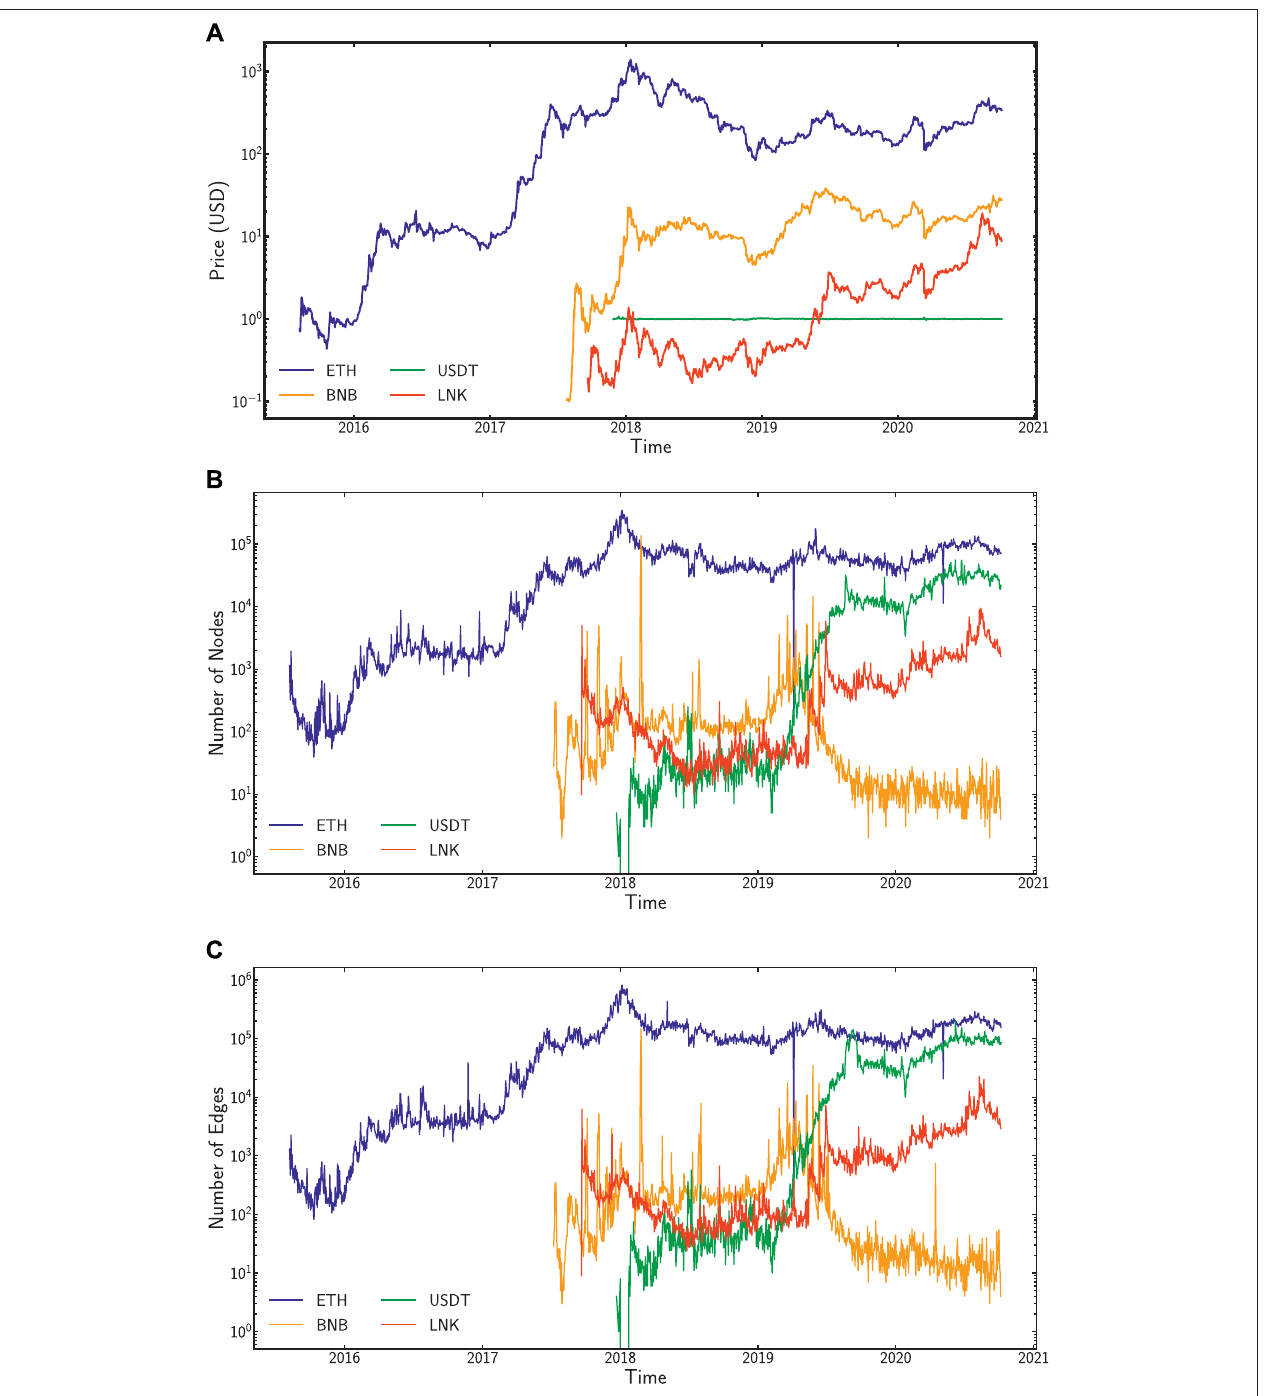
FIGURE2| Weplotbasicstatisticsofthedataanalysed.Inthe (A), weshow,asafunctionoftimetheclosingdailymarketpriceofETH,BNB,USDT,andLNKinUS Dollars. For the tokens, the time series begins with the deployment of the smart contract into the blockchain. In the (B,C), we show the number of new nodes (resp., edges) every day for the aggregate network introduced in this